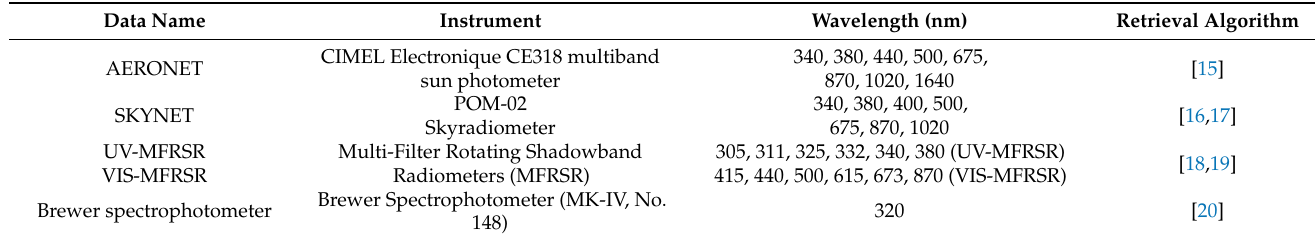
Table 2. Detailed description of ground-based AOD data used in this